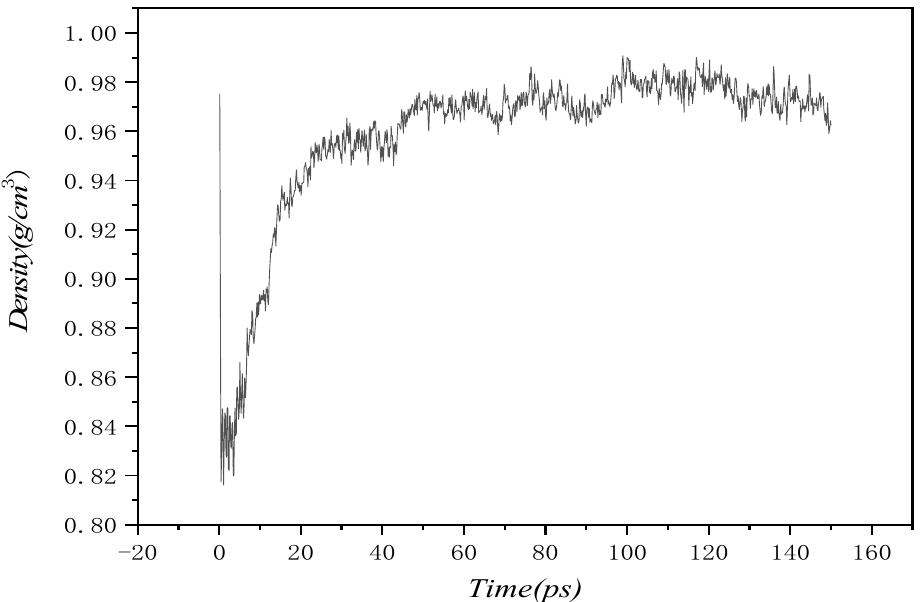
Figure 3. Density variation curve of asphalt molecular model.